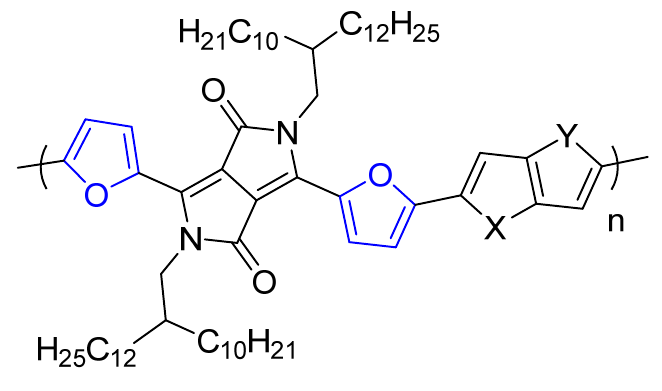
Figure 1. Structure of polymer poly(((methylthionopyrrolo)furanyl)diketopyrrolopyrrol) P(FDPP-TP)